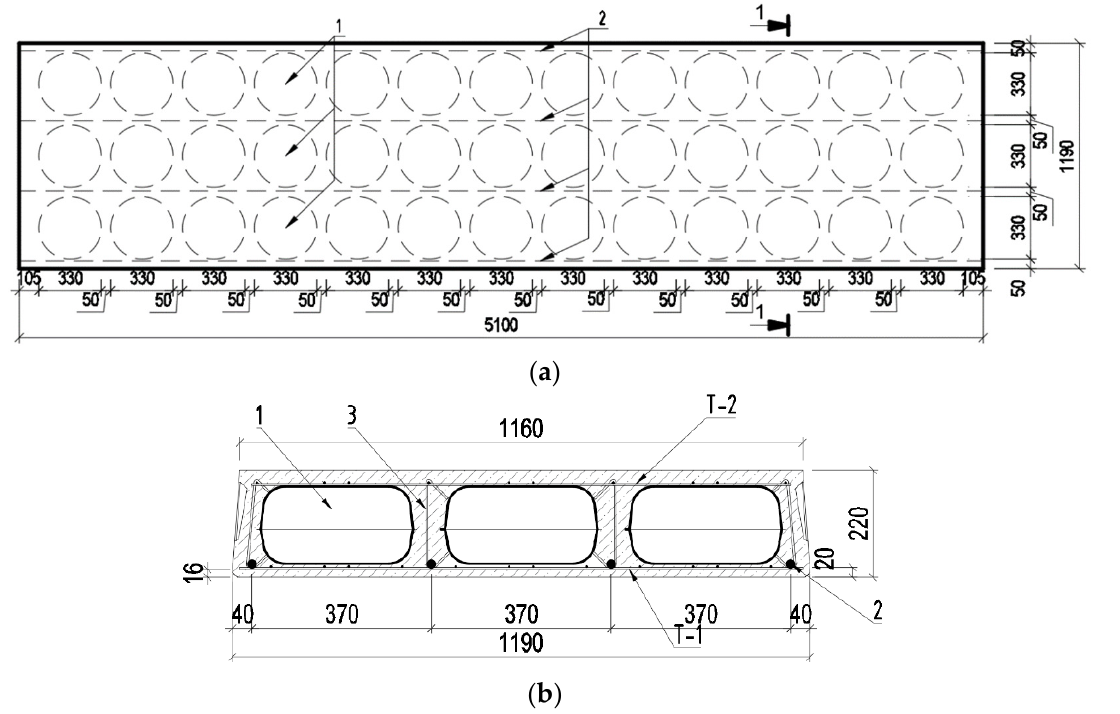
Figure 1. Designed reinforced concrete slab. ( a ) General scheme of the slab, ( b ) slab cross-section 1- 1, 1. Plastic insert; 2. Pretensioned reinforcement bars; 3. Stirrup to tie the reinforcement nets; T-1 and T-2 upper and lower reinforcement net.